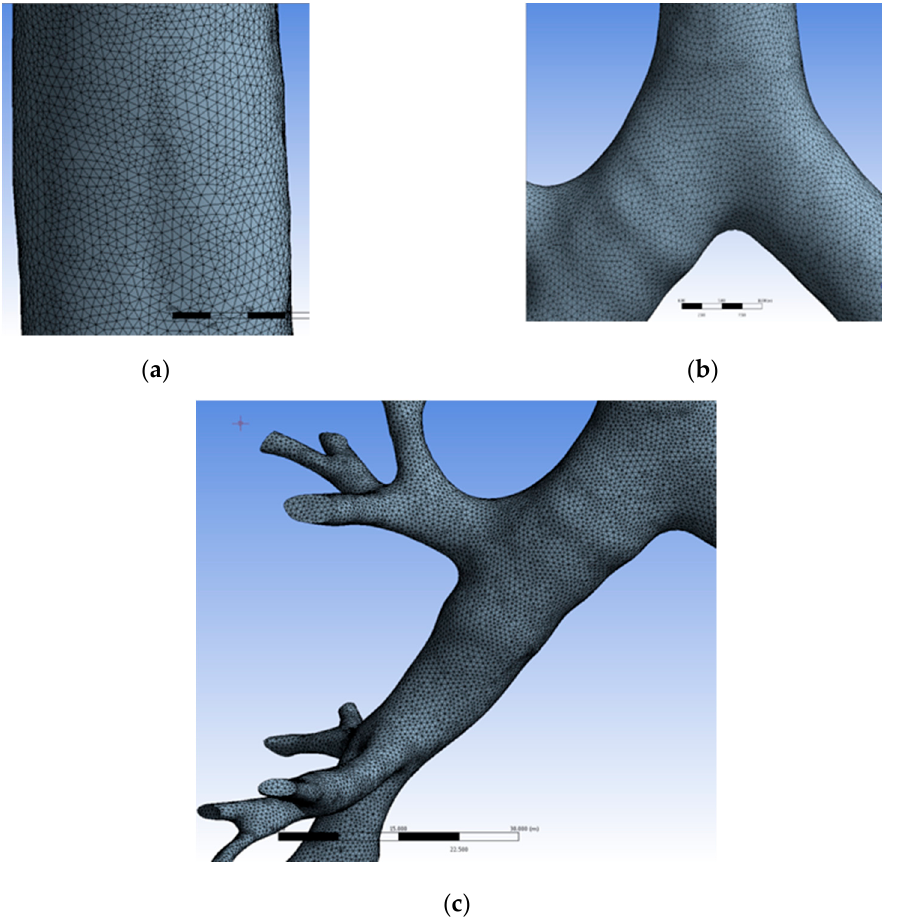
Figure 2. Computational grid in the HRT model. ( a ) Close-up view of mesh at the trachea; ( b ) Close-up view of mesh at the first bifurcation; ( c ) Close-up view of mesh at the bronchus.